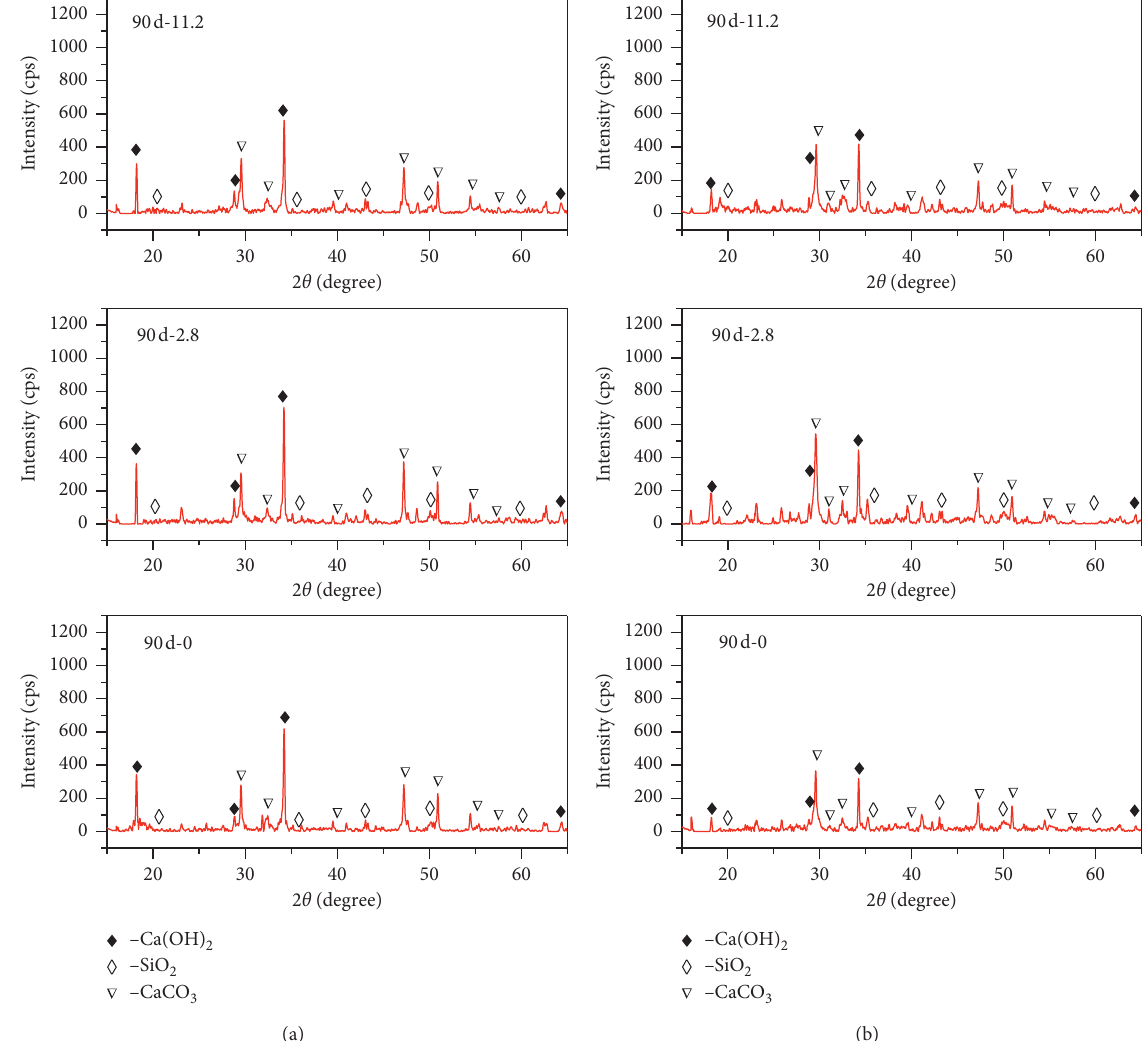
Figure 6: XRD of 90d leaching of specimens at different flow rates: (a) OPC; (b)